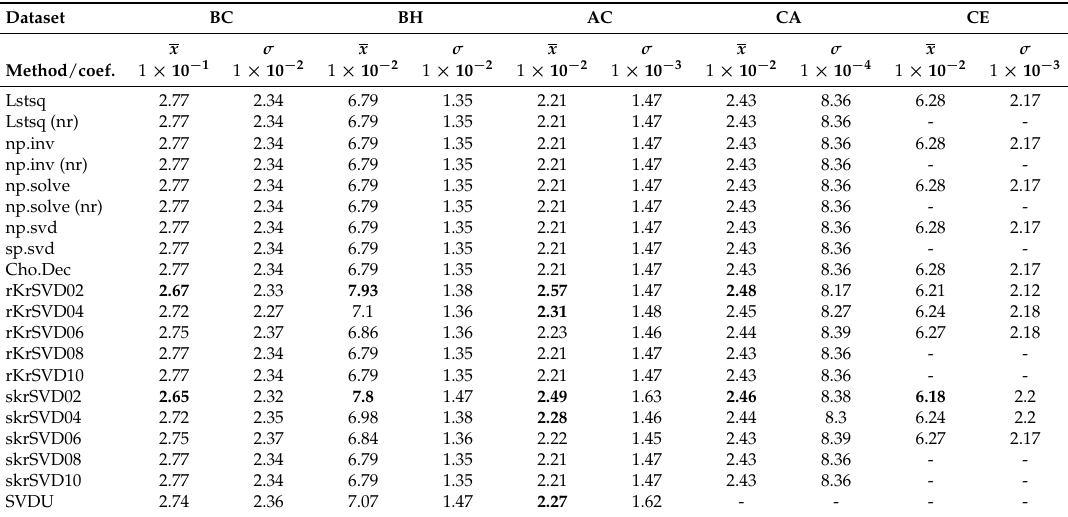
Table 3. RMSE for K = 70. Bolded numbers differ statistically from Lstsq .